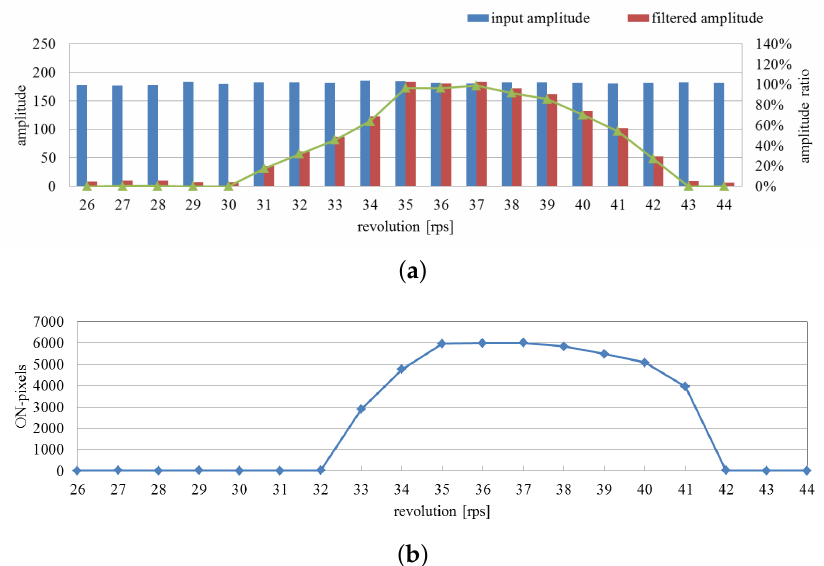
Figure 13. Averaged amplitude values and number of extracted pixels with rotation speed variation. ( a ) Averaged amplitudes of input and pixel-wise filtered images and their ratios; ( b ) number of extracted pixels as vibration